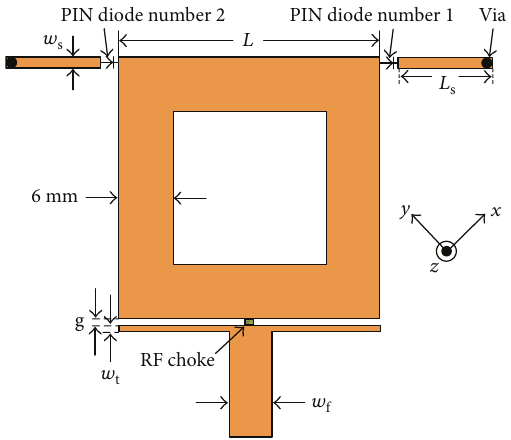
Figure 1: Dual-band recon fi gurable antenna with polarization diversity. Dimensions: L = 26mm , w = 6mm , L s = 10 mm , w s = 0 5 = 0 4mm , and w = 4 8 mm mm , g = 0 8 mm , w t f